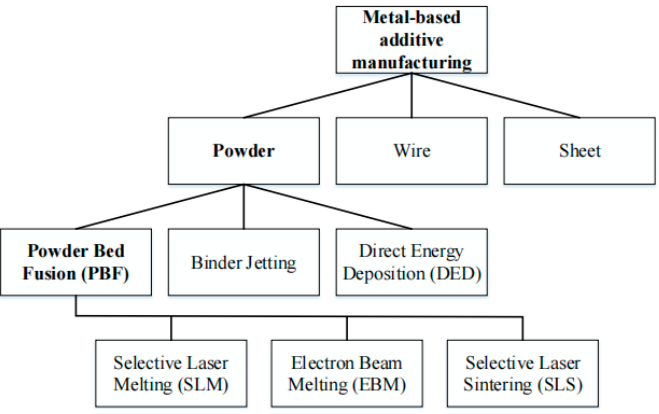
Figure 1. Overview metal − based additive manufacturing.